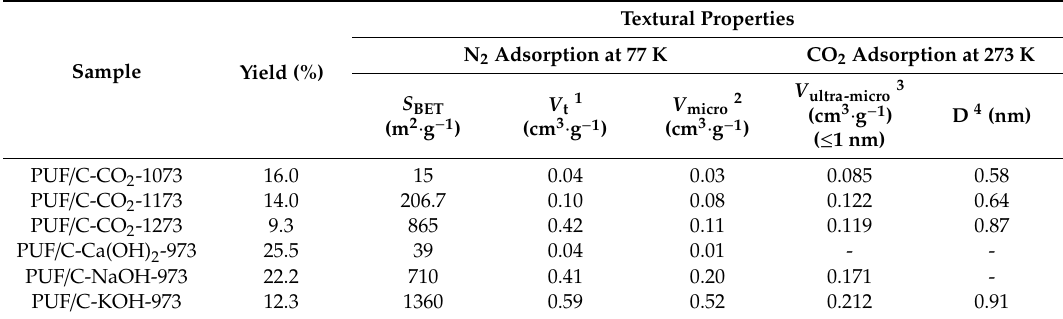
Table 2. Textural parameters of prepared samples from adsorption isotherms of N 2 and CO 2 .